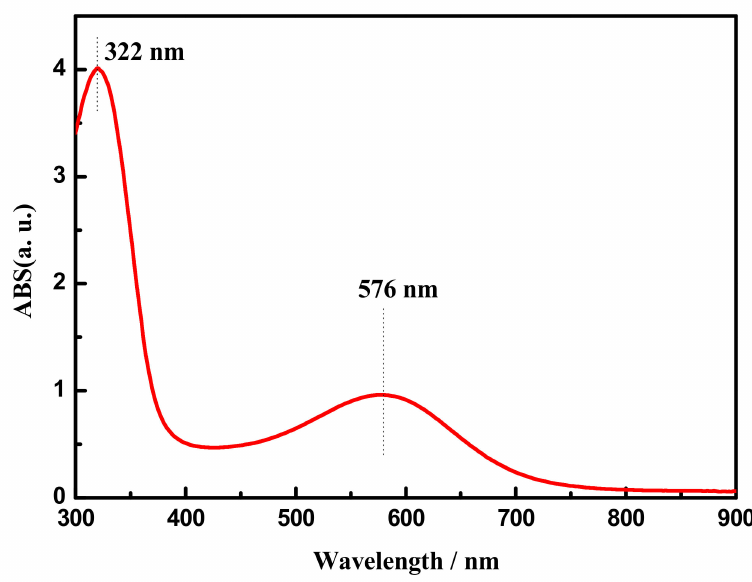
Figure 6 . Cyclic voltammogram of AT in 1 M HCl solution (aniline tetramer modified glass carbon electrode used as work electrode) . Figure 3. UV-vis spectra of aniline tetramer measured in dimethyl sulfoxide